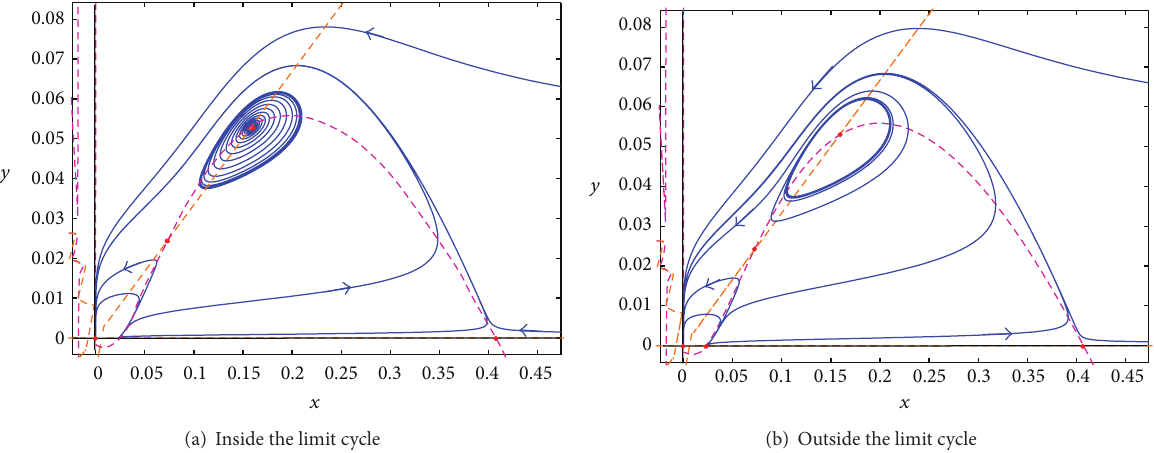
Figure 4: An unstable limit cycle coexists with a stable 𝐸 2∗ , for 𝑔 = 1.44 , 𝛿 = 0.0095 , 𝛼 = 0.84 , 𝛼 1 = 0.4 , and 𝛽 = 0.3